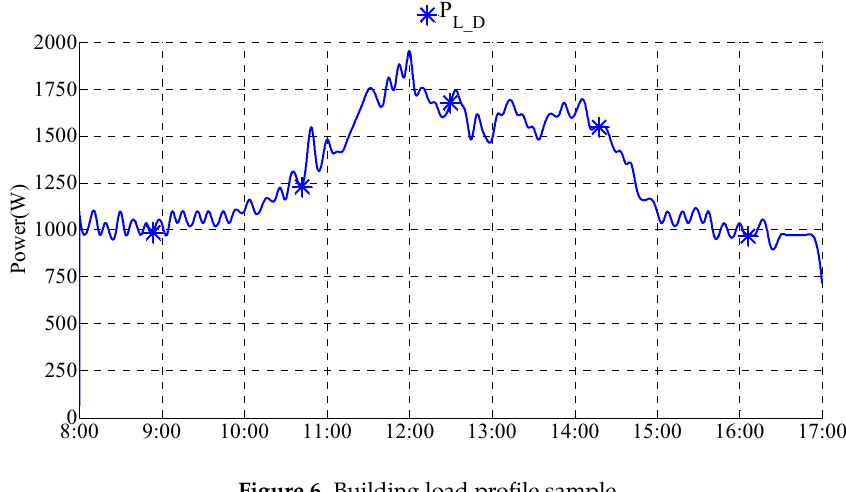
Figure 6. Building load profile sample. Table 1. Detailed appliances profile.